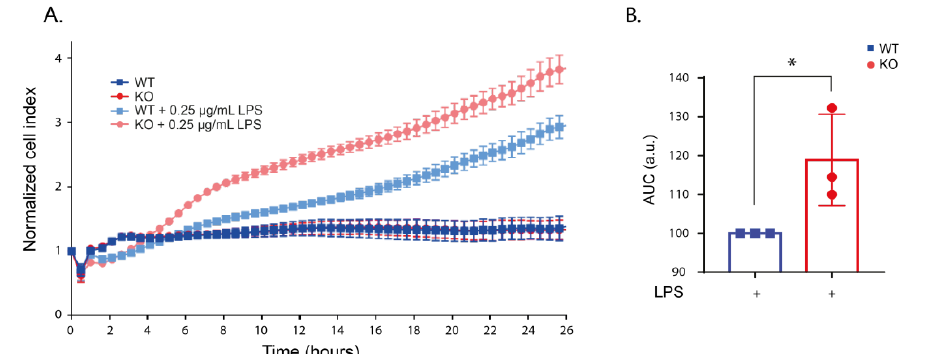
Figure 2. LPS stimulation altered the morphology of KO cells. ( A ) Representative real-time impedance measurement of the WT and KO cells with and without 250 ng/mL LPS stimulation using xCELLi- gence system. ( B ) Bar graph showing the area under curve (AUC) of 3 independent xCELLigence measurements normalized to the LPS-stimulated WT cells. t-test was used to deduce significant dif- ferences. Error bar represents mean ± SD. Significance is defined as: ns — not significant, * p < 0.05.